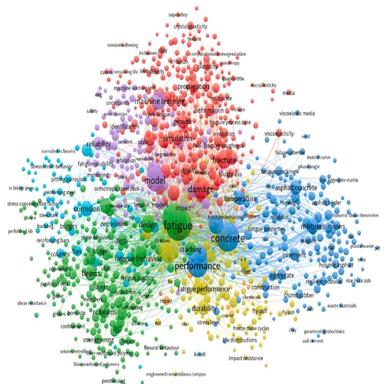
Keyword network analysis of articles on fatigue of cementitious materials from the Scopus database.